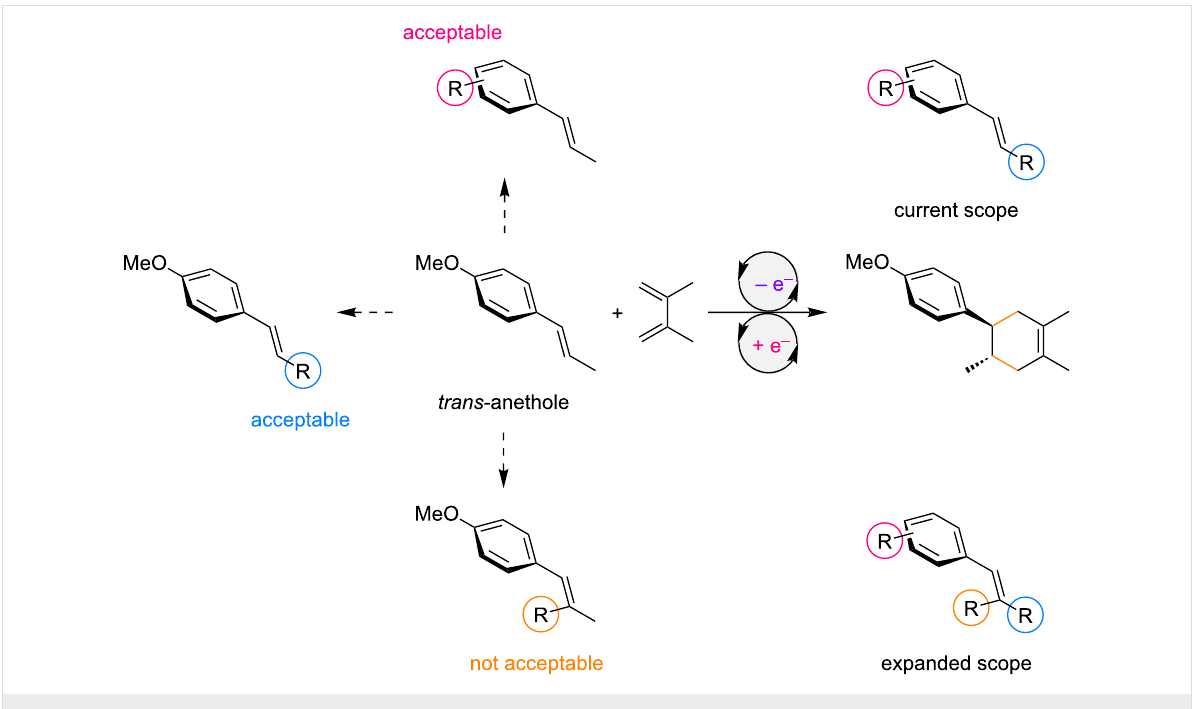
Figure 2: Landscape of the radical cation Diels–Alder reaction.